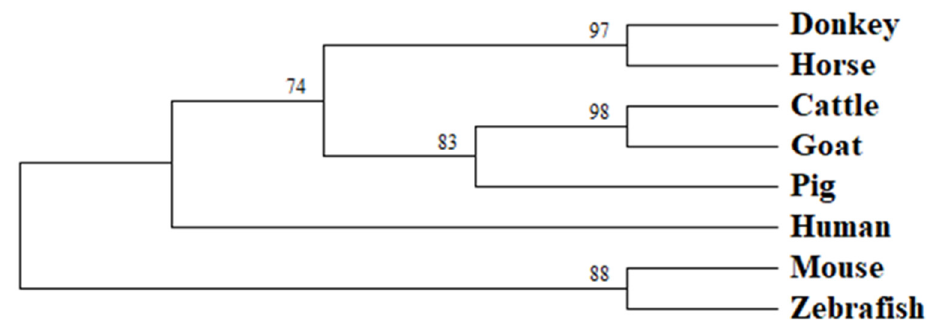
Figure 2. The phylogenetic tree of the HOXC8 gene in different species. The number on the internal node represents support value and is used to represent the reliability of this branch structure.